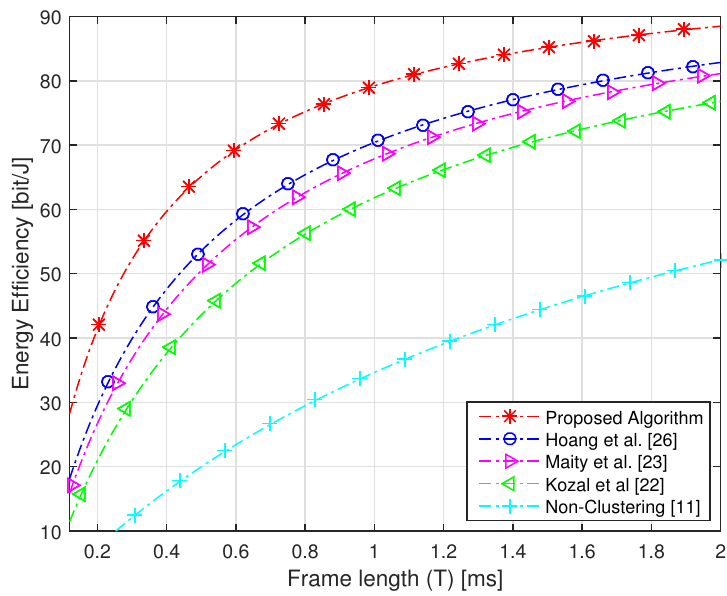
Figure 6. Energy efficiency with an increasing time